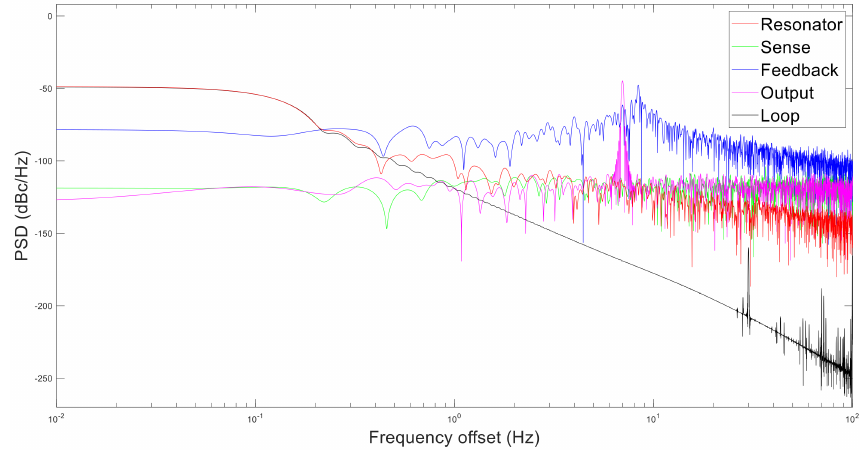
Figure 14. Phase noise of each part in simulation.